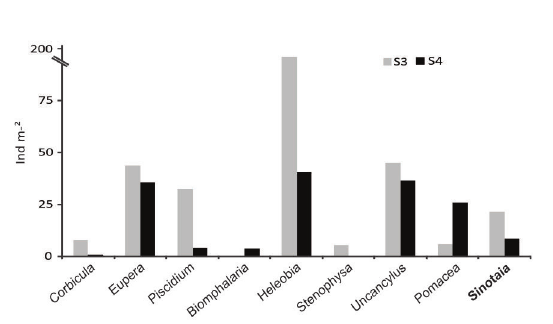
Figure 2 - Mean density of molluscs at sites 3 (S3) and 4